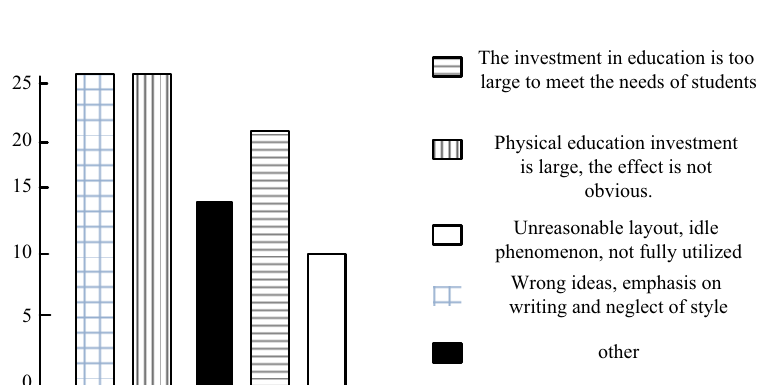
Figure 4: Assisted teaching satisfaction.